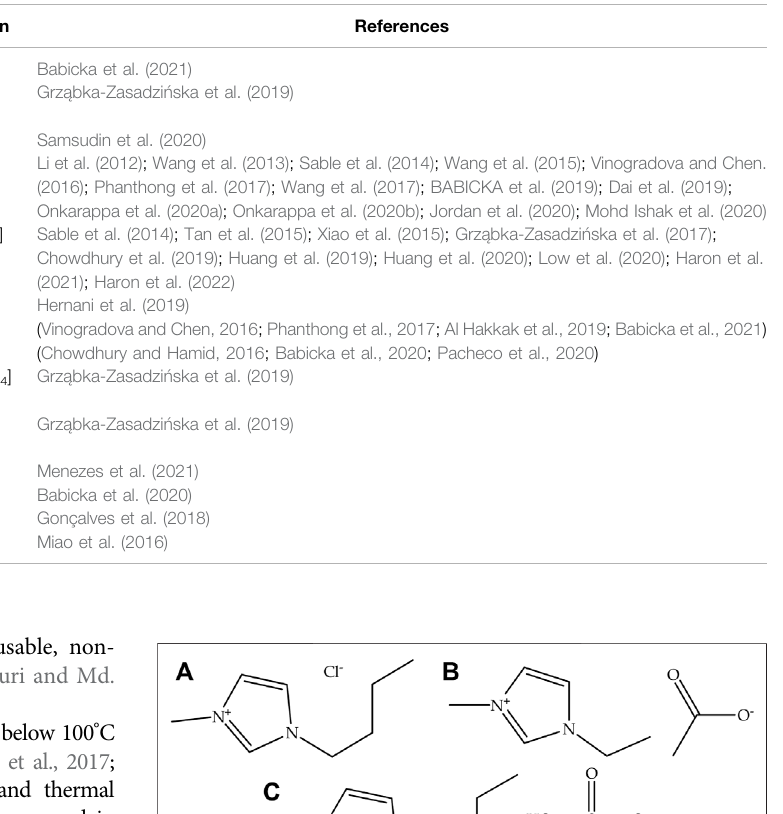
TABLE 1 | Examples of ionic liquids used for the extraction of